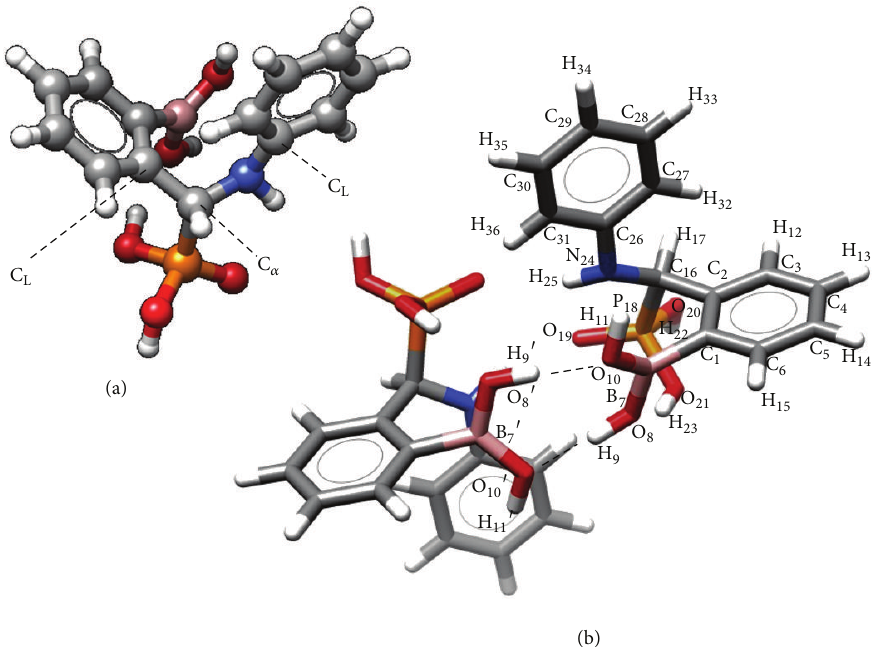
Figure 1: The molecular structure of [PhN-(2-PhB(OH) 2 )- R -Me]PO 3 H 2 monomer (a) and dimer structure (b) (where C atom of the aromatic ring connected to the aliphatic